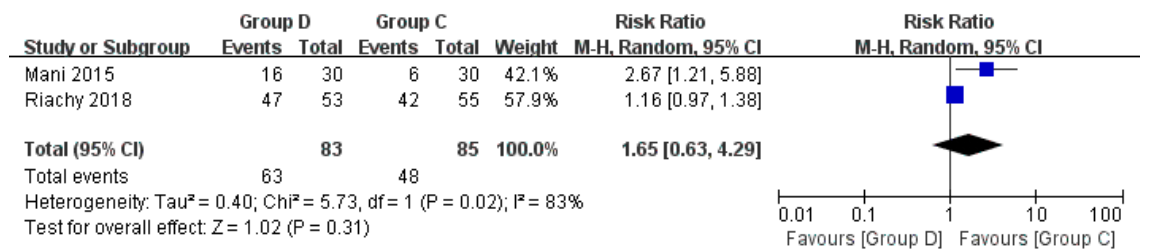
Figure 10. Forest plots comparing the effects of dexmedetomidine and control group on arrhythmia [24,27].